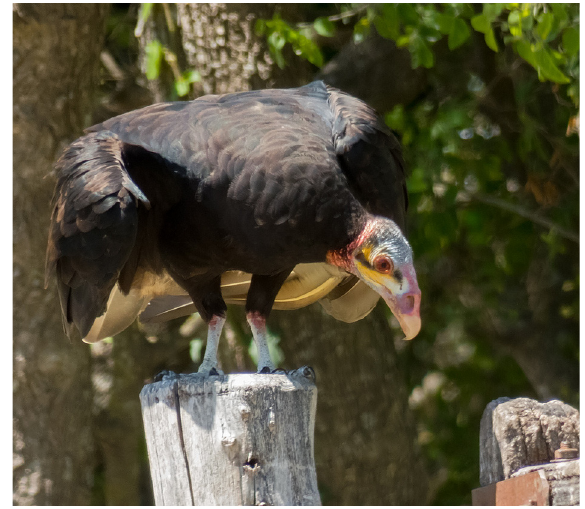
Figure 2. Lesser Yellow-headed Vulture ( Cathartes burrovianus ) observed on 8 January 2018 in Estancia Luis Chico, Punta Piedras, north-eastern Buenos Aires province, Argentina (photograph by